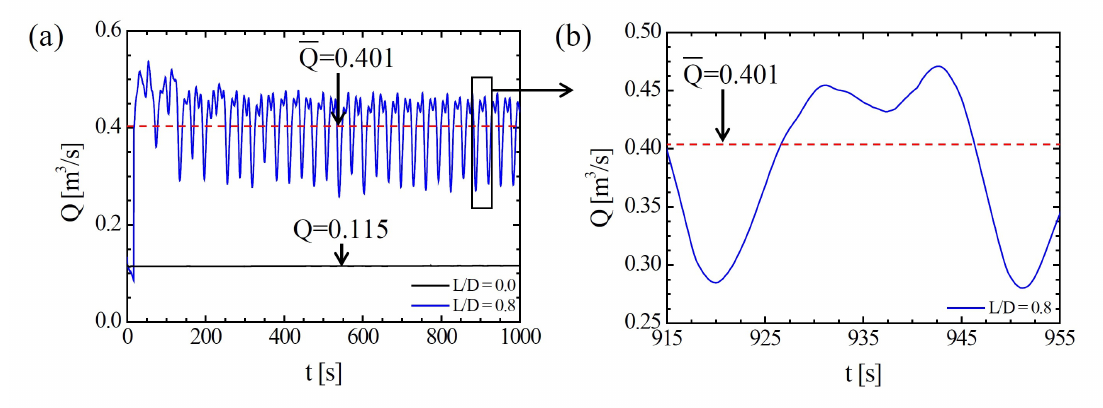
Figure 4. Time histories of ventilation rates ( a ) for a single-sided building without an overhang and with an overhang at L / D = 0.8 in the windward direction for the entire simulation period and ( b ) for the building with an overhang at L / D = 0.8 for a dominant quasi-periodic